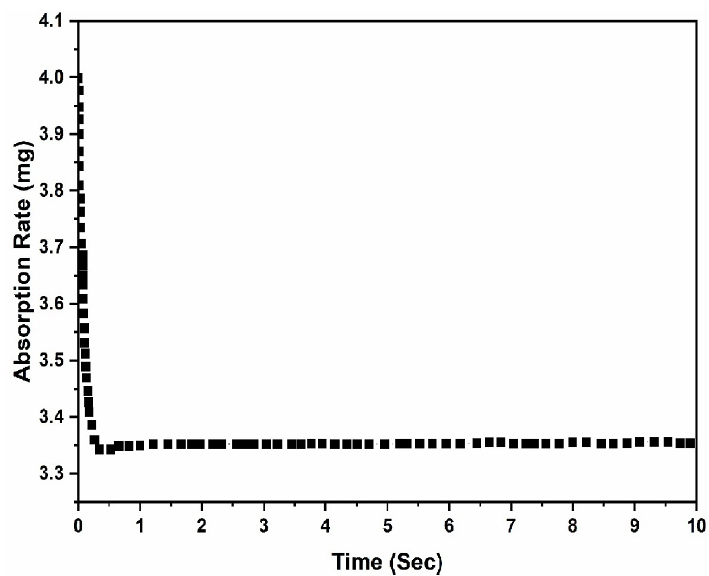
Figure 13 . Response of the System with